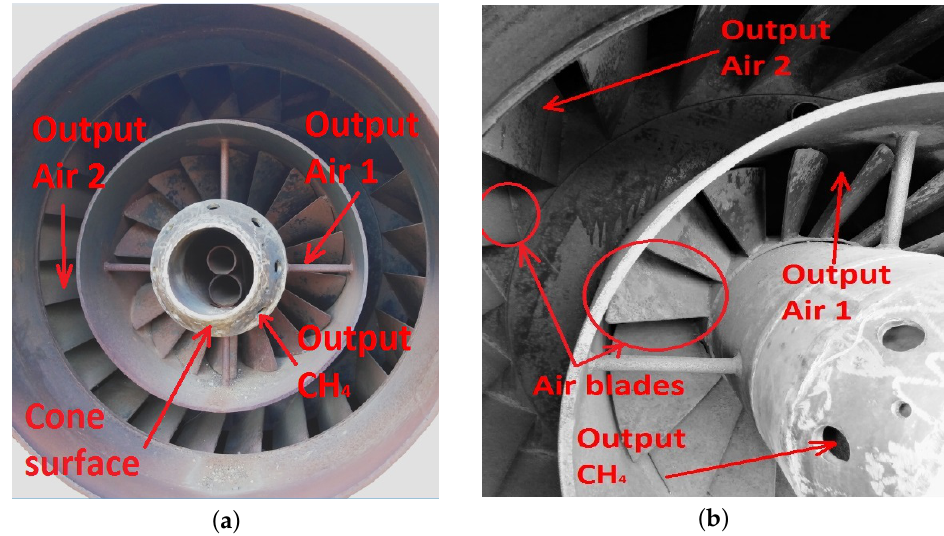
Figure 2. Operating burner device type GMU-45 boiler type E-500-13.8-560GMN: ( a ) general view; ( b ) enlarged view of the